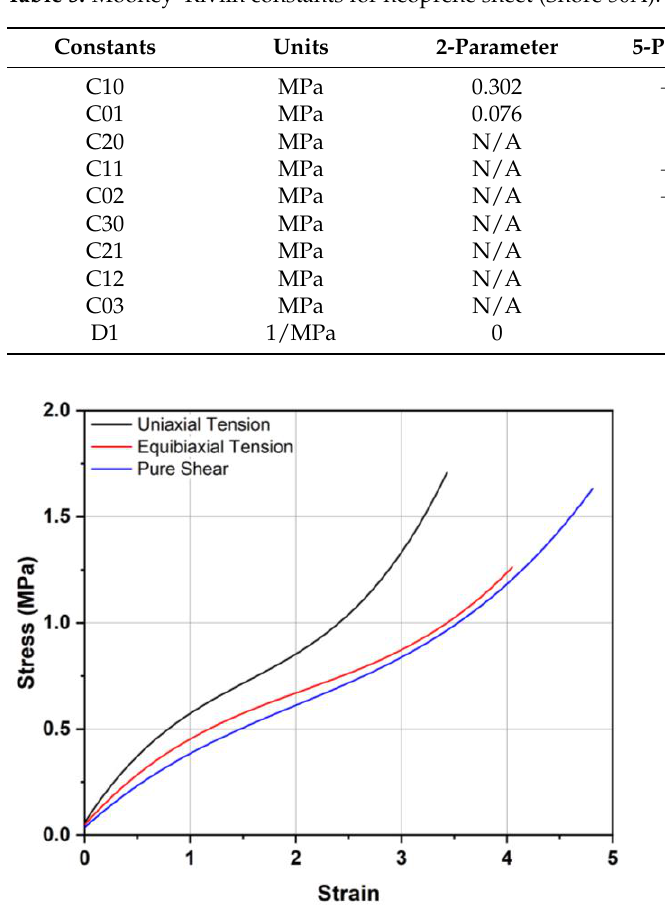
Figure 6. Material behavior curve for the Mooney–Rivlin hyperelastic model.